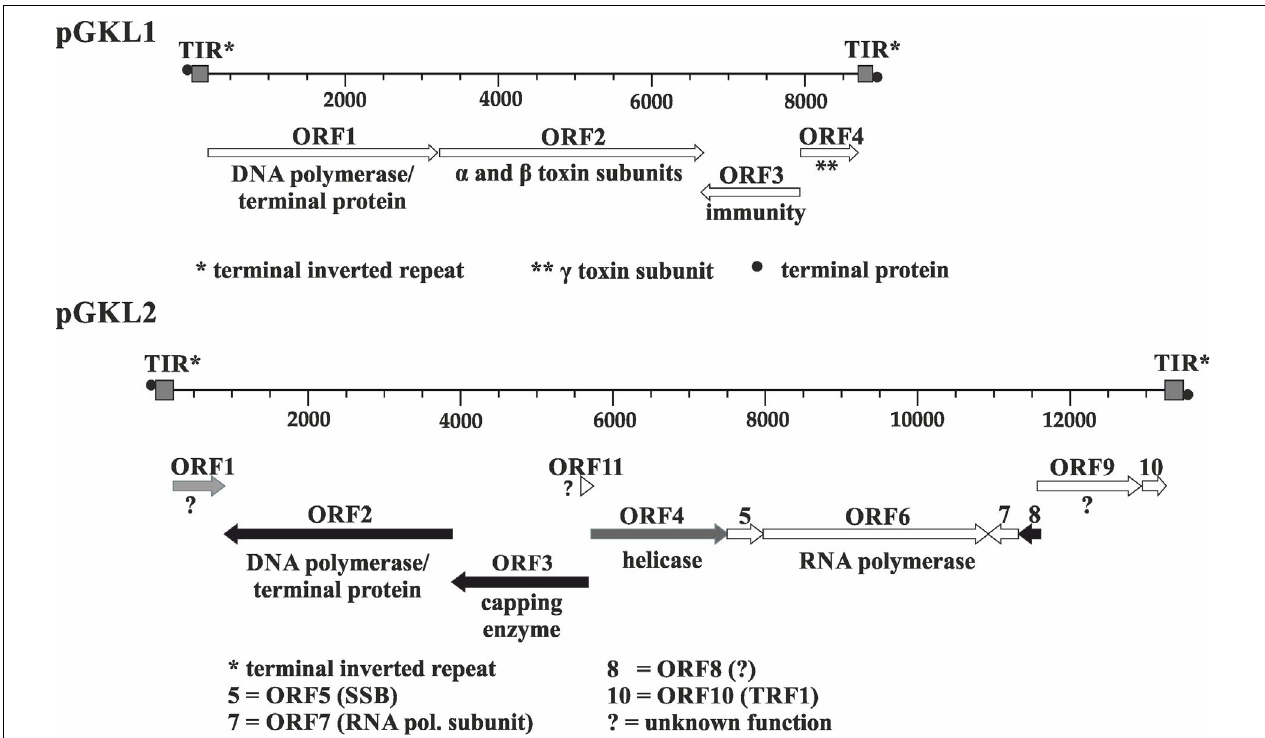
FIGURE 1 | Genetic organization of pGKL VLEs (linear cytoplasmic plasmids). Known gene functions are indicated. Shades of gray indicate the extent of transcript capping as determined in this work, from black ORFs ( > 85% mRNAs 5 (cid:48) capped) to white ORFs ( < 35% mRNAs 5 (cid:48) capped). Transcripts from gray ORFs comprise 45–60% 5 (cid:48) capped mRNAs and represent an intermediate degree of capping. All pGKL1 ORFs belong to the group with a low occurrence of 5 (cid:48) capped transcripts. TIR, terminal inverted repeat; • , terminal protein; SSB, single-stranded binding protein; TRF1, terminal recognition factor 1; ?, unknown protein